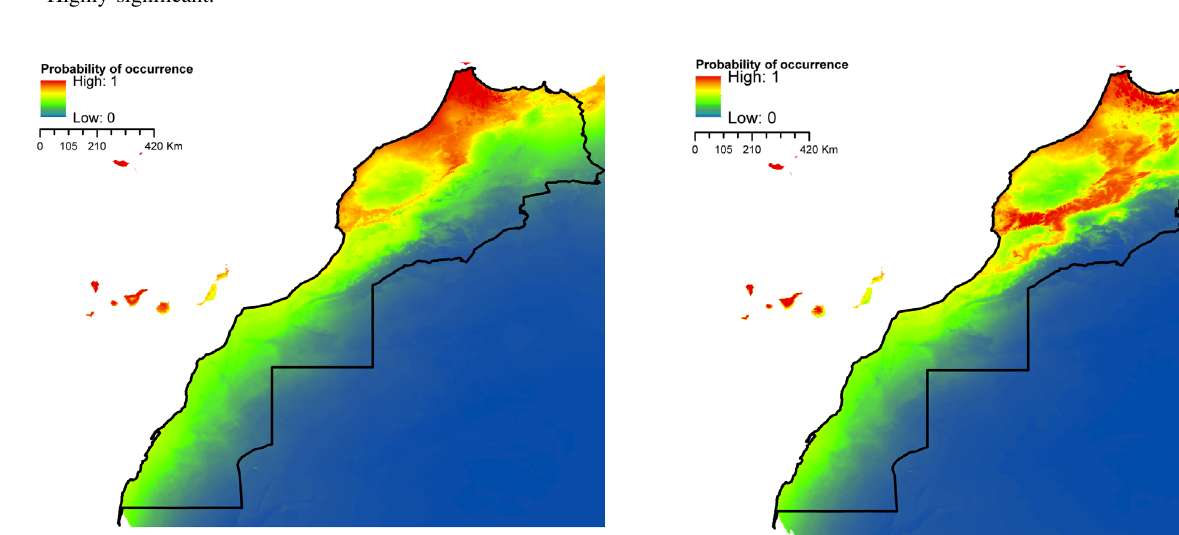
Figure 2. Predicted probability of Ae. vexans occurrence in